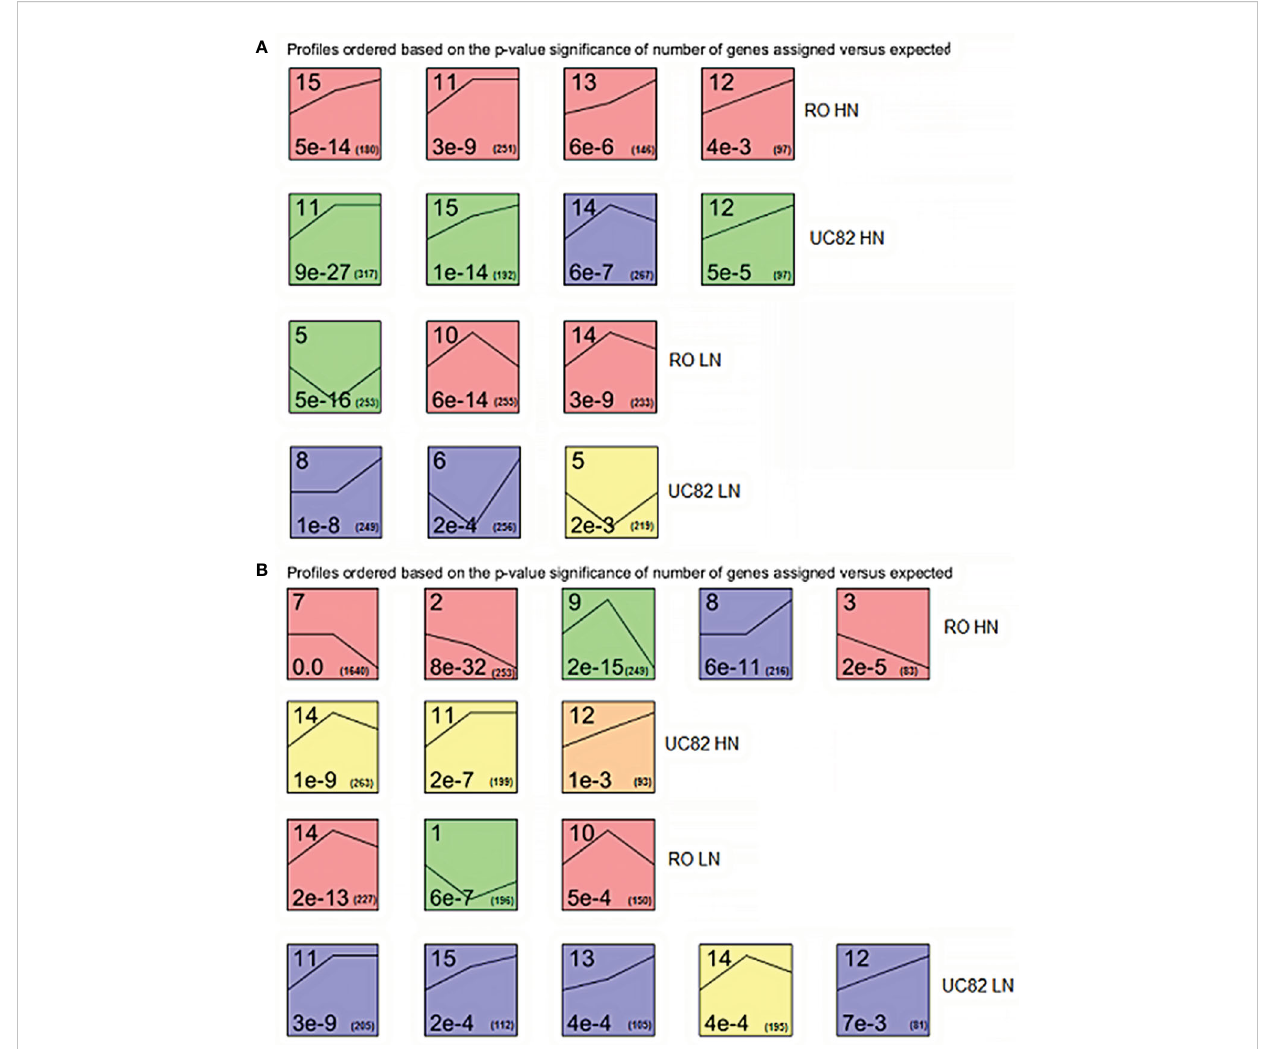
FIGURE 2 Signi fi cant enriched temporal expression pro fi les of the DEGs identi fi ed between genotypes, times, N levels, and their interactions in shoot (A) and root (B) . The number on the top refers to the cluster number. The numbers at the bottom are the P -values (left) and the gene number (right) assigned in each cluster, respectively. The lines inside each square represent the trend at the three experimental time points for each